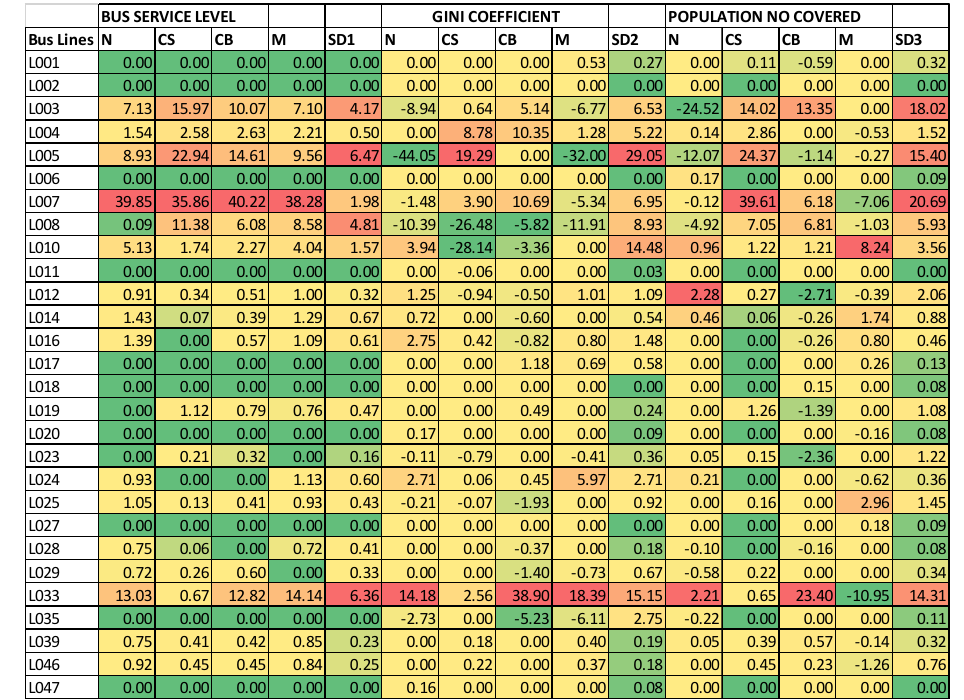
Figure 8. Explained percentage of variance on Bus Service Level, Gini coefficient, and Uncovered Population, derived from bus frequencies variation. [N] Neighbourhoods; [CS] Census sections; [CB] Cadastral blocks; [M] 400 × 400 m mesh. [SD1], [SD2], and [SD3] Standard Deviation of the variance for each line for BSL, Gini coef., and PNC, respectively. Bus line A2 was not included, due to its low significance.